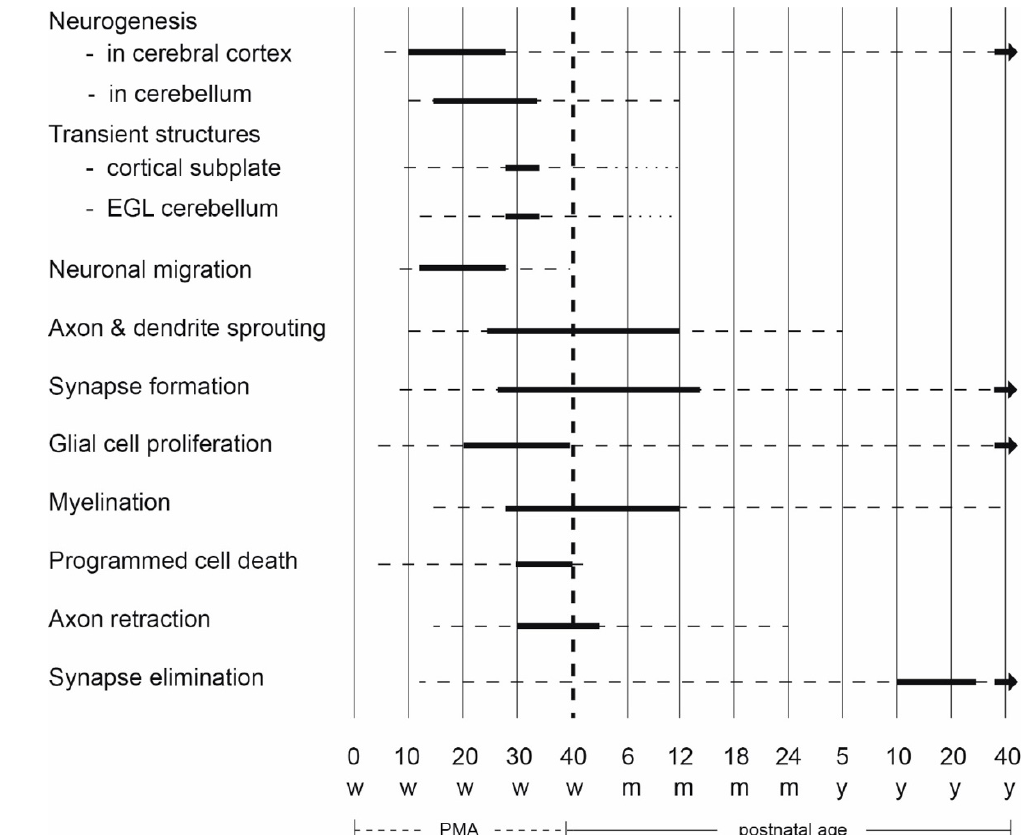
Figure 1. Schematic overview of the developmental processes occurring in the human brain. The bold lines indicate that the processes mentioned on the left side are very active, the broken lines denote that the processes still continue but less abundantly. The diagram is based on reference [17]. EGL = external granular layer; m = months; PMA = postmenstrual age; w = weeks; y = years. Figure reproduced with permission from ‘Early Detection and Early Intervention in Developmental Motor Disorders—from neuroscience to participation’ by Mijna Hadders-Algra (ed.) published by Mac Keith Press in its Clinics in Developmental Medicine Series, ISBN number 978-1-911612-43-8 [16].